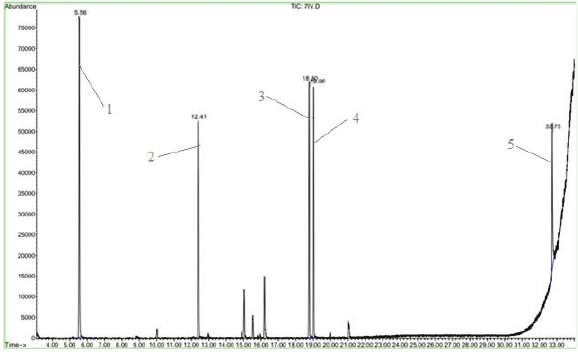
Figure 3. Chromatogram of carbohydrates formed as a result of enzymatic hydrolysis in the herbal mixture No. 4 (1 – arabinose, internal standard; 2 – glucose; 3–4 – fructose).